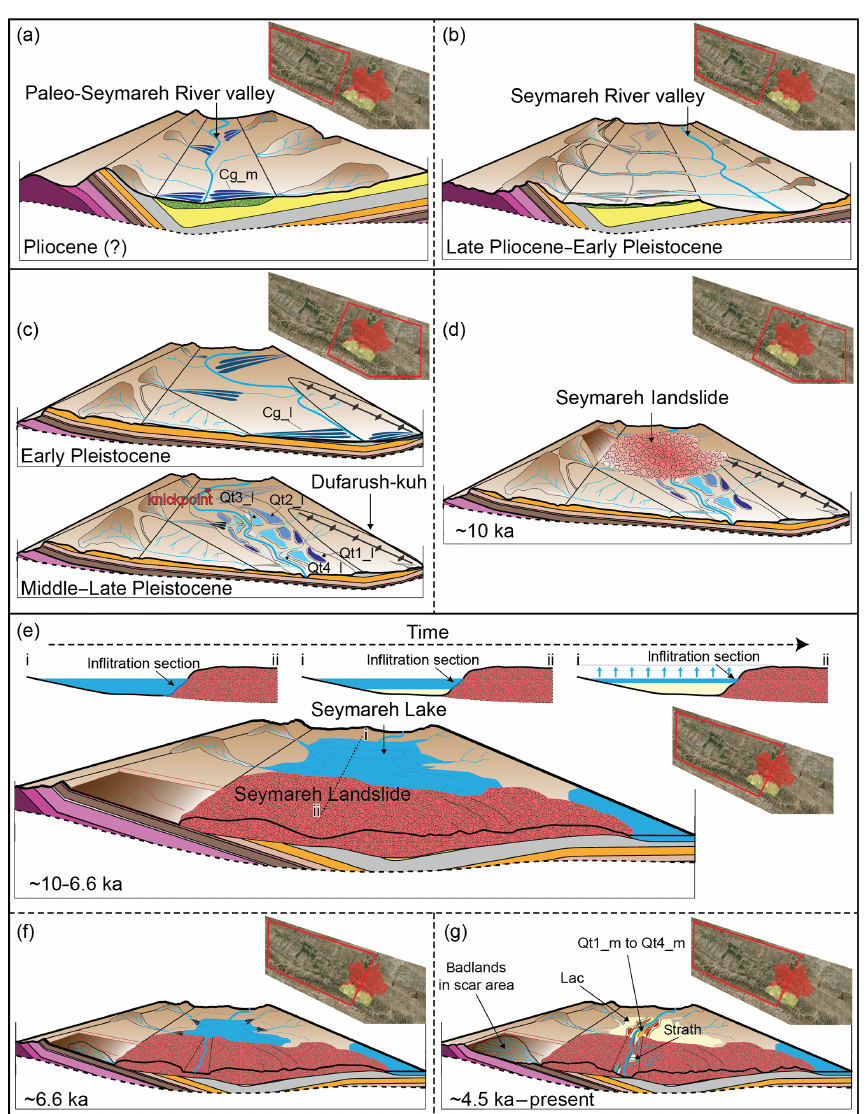
Figure 12. Evolutionary model of the Seymareh River valley. See text for explanation. Traces and legend of geological cross sections are reported in Fig.